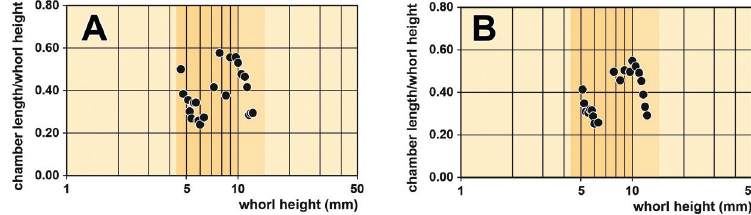
Fig. 49. Lituites procerus Remelé, 1890, chamber length/whorl height of specimen MB.C.30547 (Krueger Coll.) from Oderberg (Brandenburg). A . Empirical data. B . Three data point